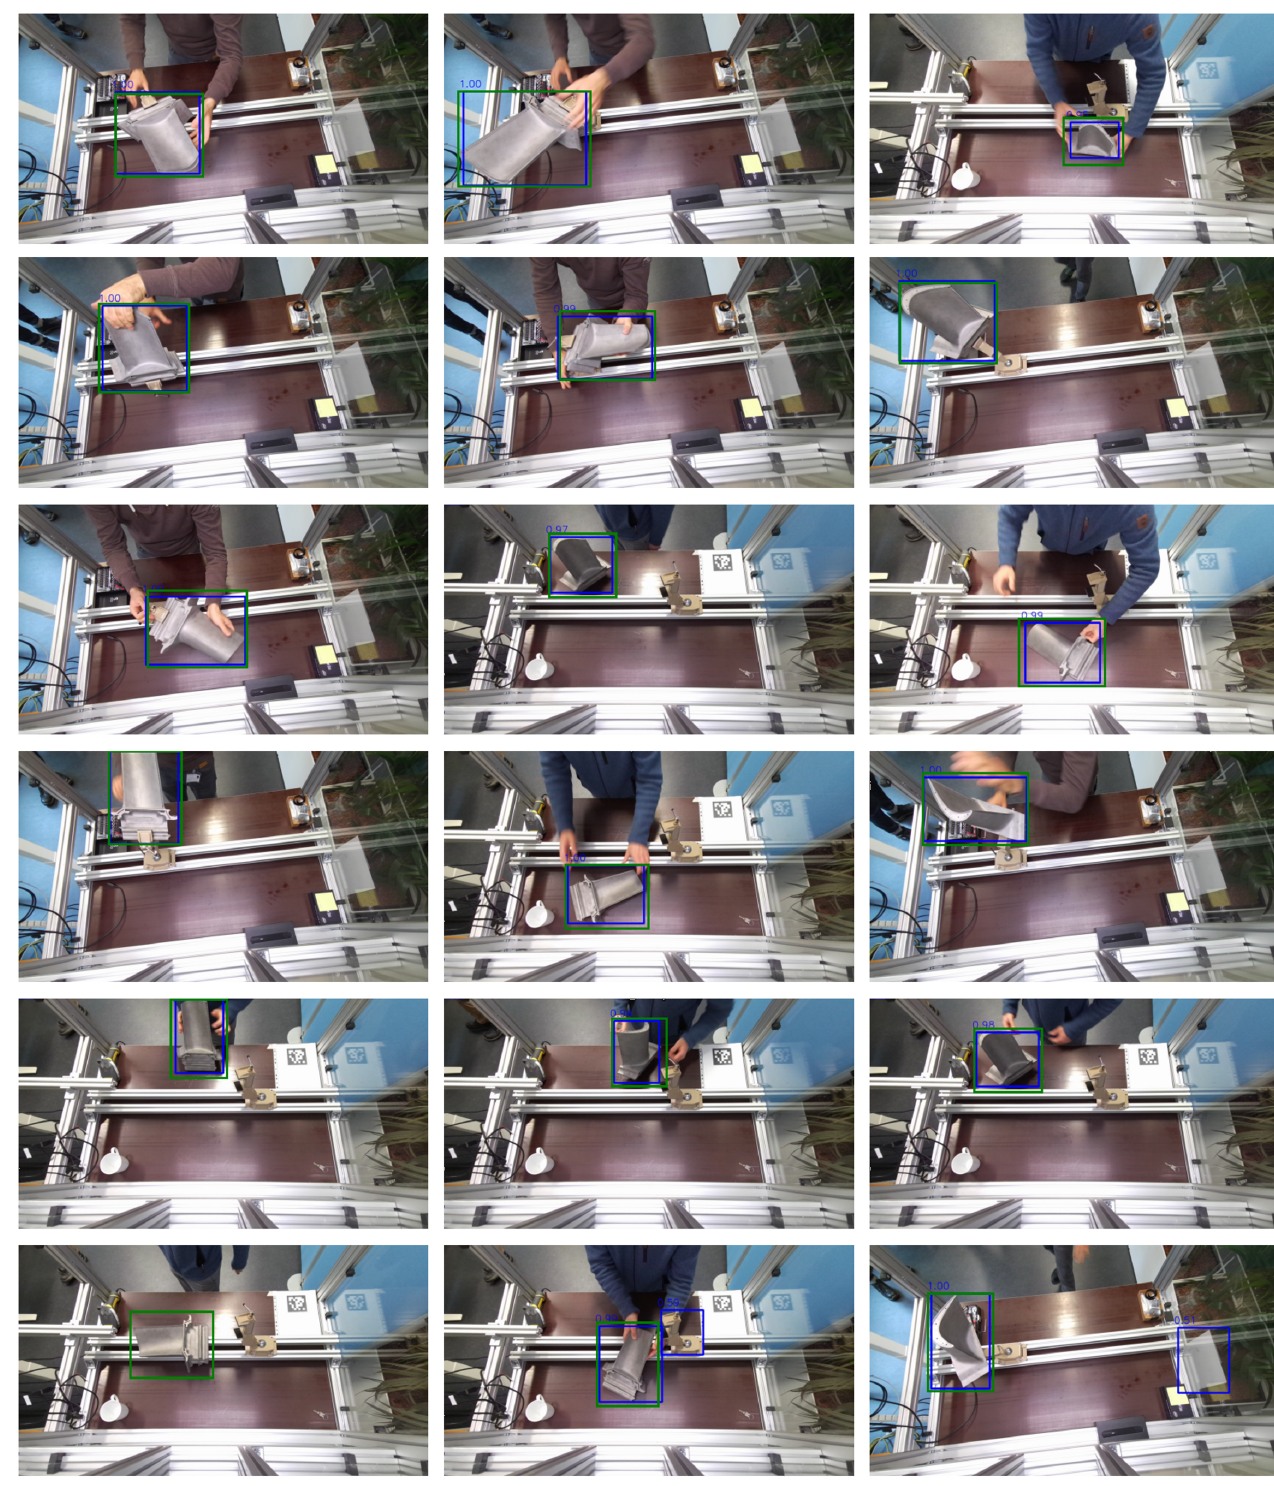
Figure 1. Object detection results on real validation data from our Faster R-CNN model trained purely on 5000 synthetic PBR images. Predictions are blue (including detection confidence) and manually created ground truth labels are green. The last row shows some